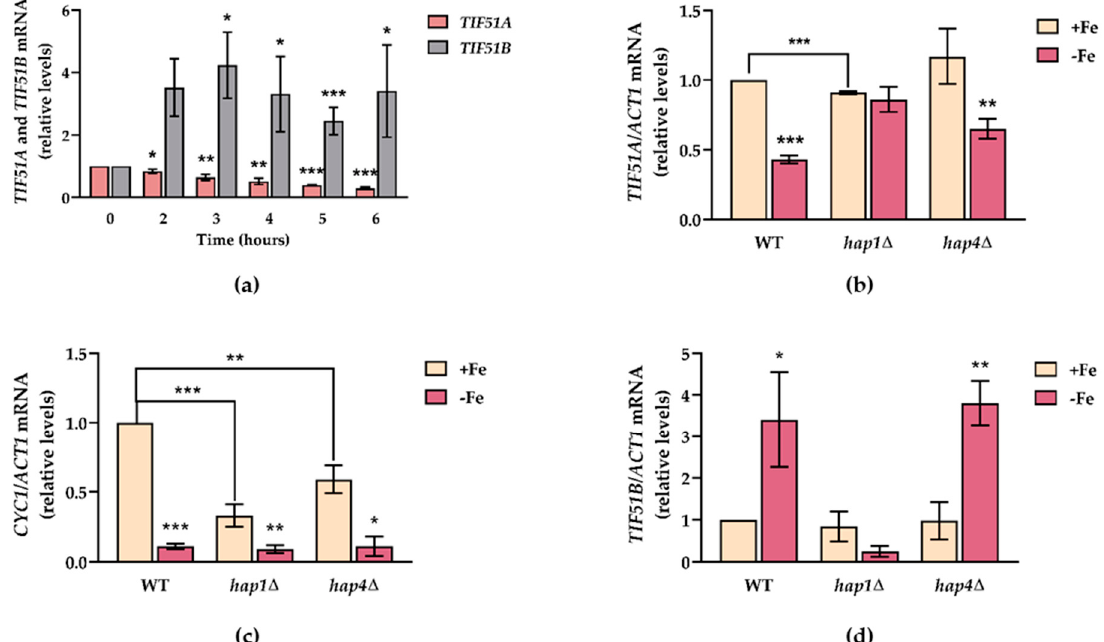
Figure 6. Iron deficiency down-regulates TIF51A and up-regulates TIF51B in a Hap1-dependent manner. ( a ) The WT cells were grown in SC medium with the addition of 100 mM BPS and samples were collected at the indicated time points. The relative TIF51A and TIF51B mRNA levels were determined. The results are expressed in relation to the value at time 0. ( b – d ) The WT, hap1 ∆ and hap4 ∆ strains were grown in SC medium with or without the addition of 100 mM BPS for 7 h. The relative TIF51A ( b ), CYC1 ( c ) and TIF51B ( d ) mRNA levels were determined. The results are expressed in relation to the value of the WT strain without treatment. ( a – d ) The results are shown as the means ± SD of three independent experiments. Statistical significance was measured by a Student’s t -test. * p < 0.05, ** p < 0.01, * p < 0.001.